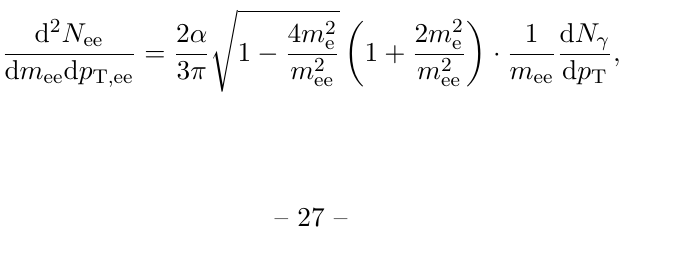
Figure 16 . (Colour online) Inclusive e + e (cid:0) cross section in pp collisions at ALICE acceptance as a function of p T ; ee (left panel) and DCA ee (right panel) in the mass range 2.7 < m ee < 3.3 GeV/ c 2 . The data are compared with a cocktail of expected sources. In the bottom panels, the ratio of data to cocktail as a function of p T ; ee (left) and the pull distribution as a function of DCA ee (right) are shown. Statistical and systematic uncertainties on the data are plotted as verti- cal bars and boxes, respectively. The total uncertainty of the cocktail is represented as a grey